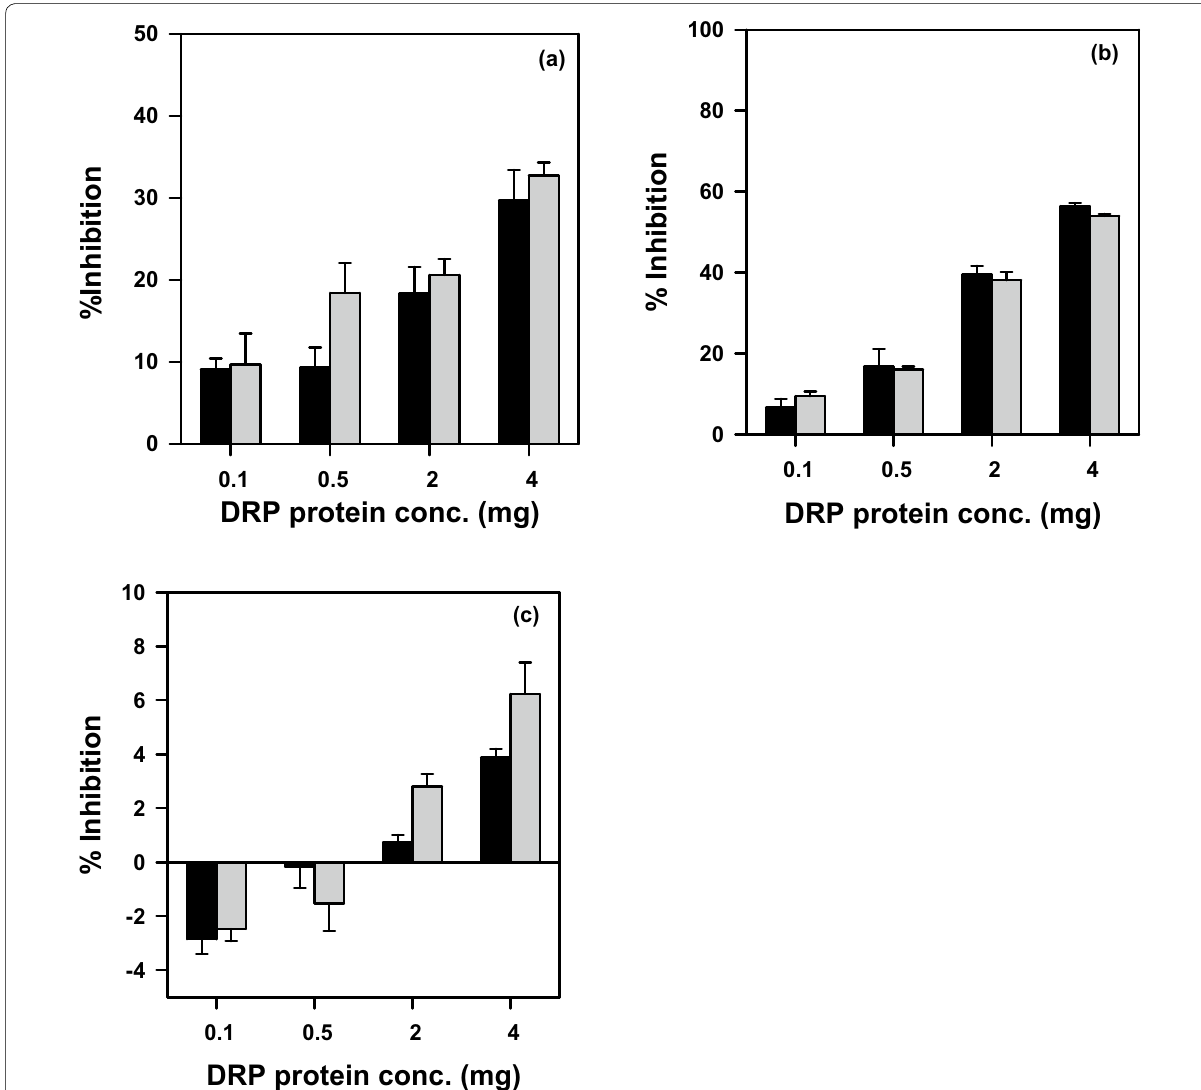
Fig. 6 Functional test based on ( a ) DPPH, ( b ) Hydroxyl, and (c) Superoxide radical scavenging activity of DRP protein, which cultured at 25 °C (black bar) and at 30 °C (grey